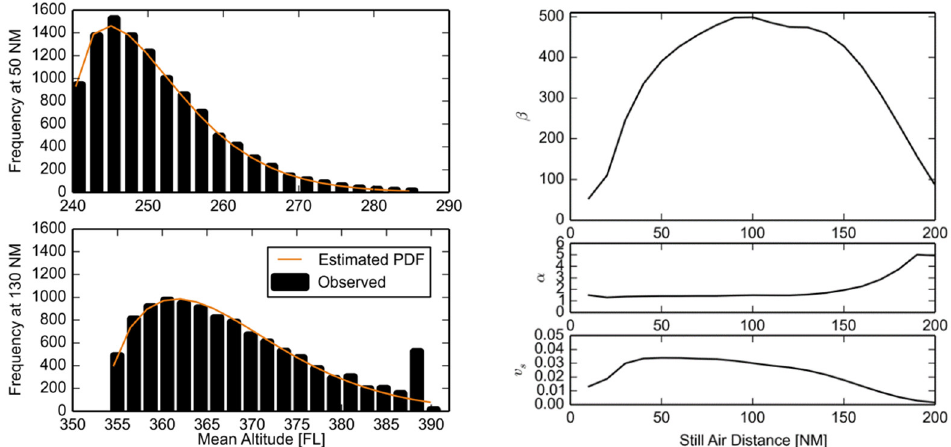
Figure 8. Classified observed altitudes (VTU) at 50 NM (top, left) and 130 NM (bottom, left) still air distance from the Monte Carlo simulation. The assumed Weibull-input PDF fits to the observed VTU distribution until 100 NM of still air distance. The shape parameter β (top, right), the scale parameter α (middle, right) reach similar values, as chosen for the input PDF of the ATOM. For distances longer than 100 NM, the χ 2 Test of Weibull-distribution did not pass. Small values of the coefficient of variation v s (bottom, right) indicate a decreasing influence of ATOM on VTU during cruise due to a predefined cruising altitude.